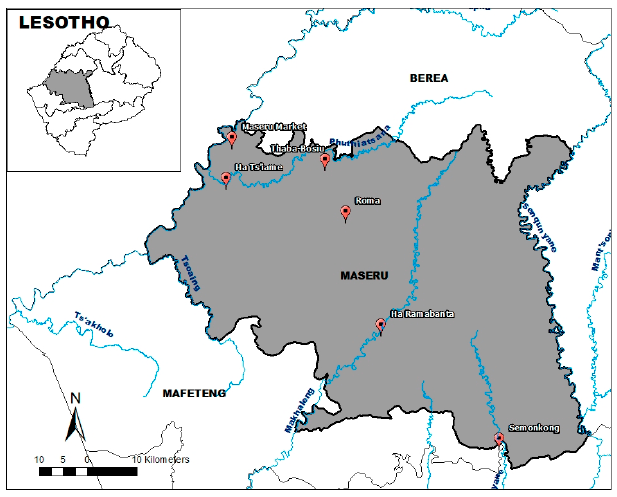
Figure 1. Map of the study area (source: L. Motjotji).